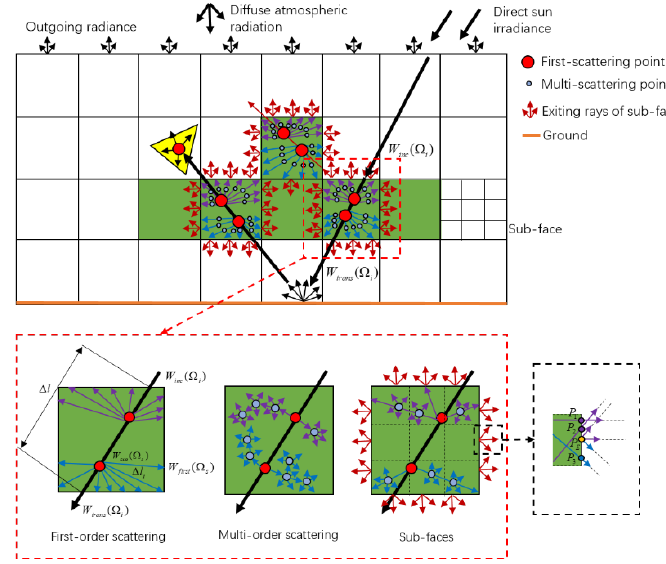
Figure 6. Radiation tracking in non-empty voxels.